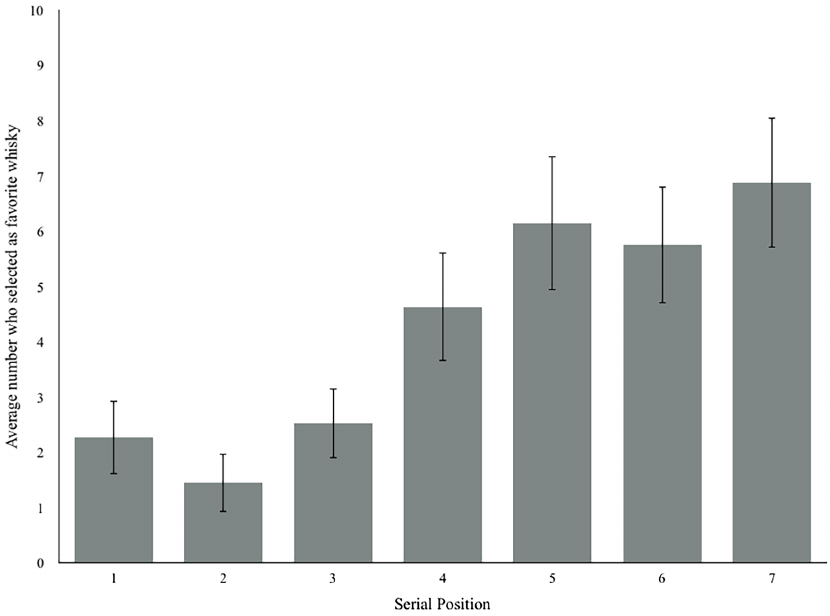
Fig 1. Mean number of people who selected whiskies in each serial position as their favorite after the first tasting. Error bars represent 95% confidence intervals of the mean.